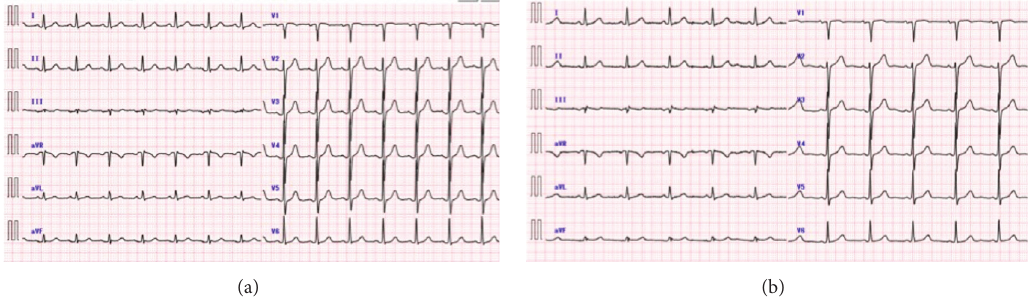
Figure 1: Electrocardiogram before (a) and after (b) the PCI.